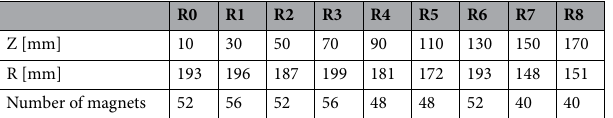
Table 2. Variable-diameter elliptical magnet ( ε = 0.64 )—design parameters.